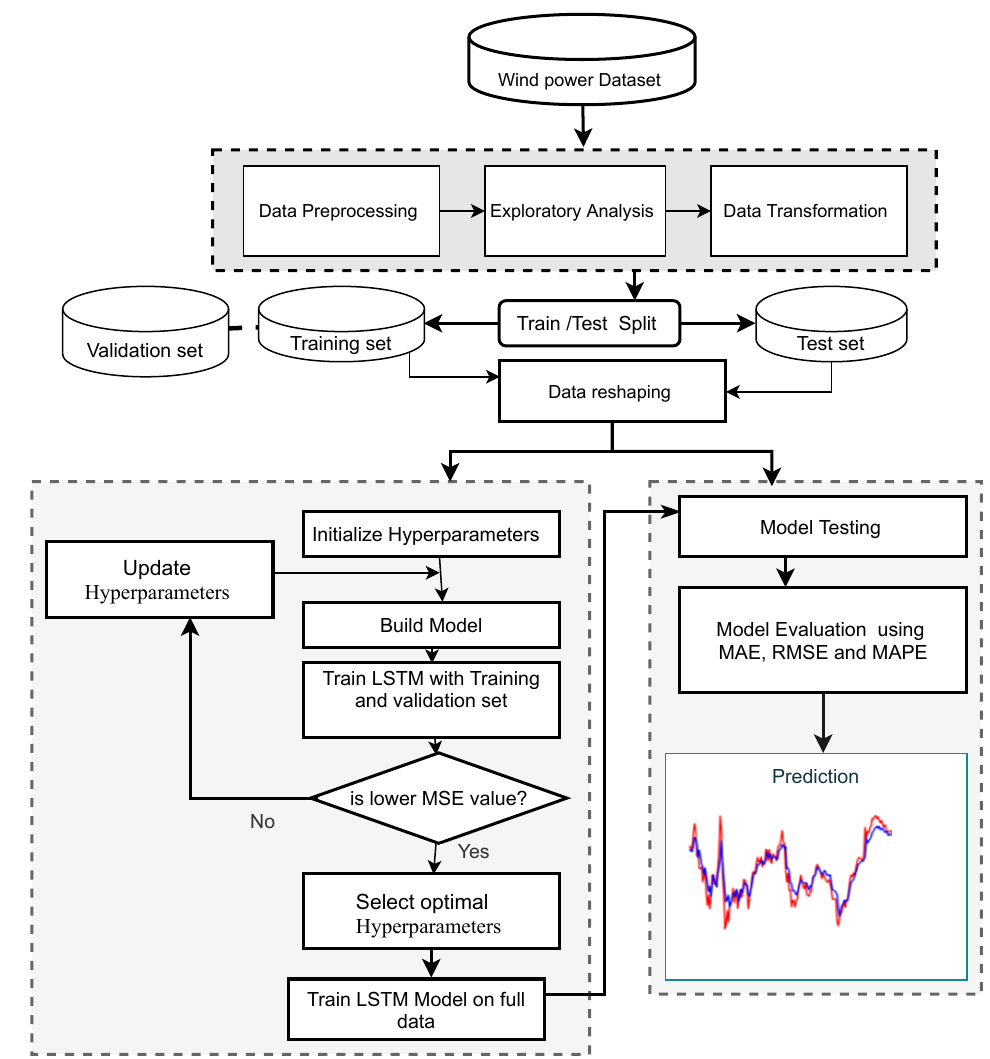
Figure 1. Proposed methodology for wind power